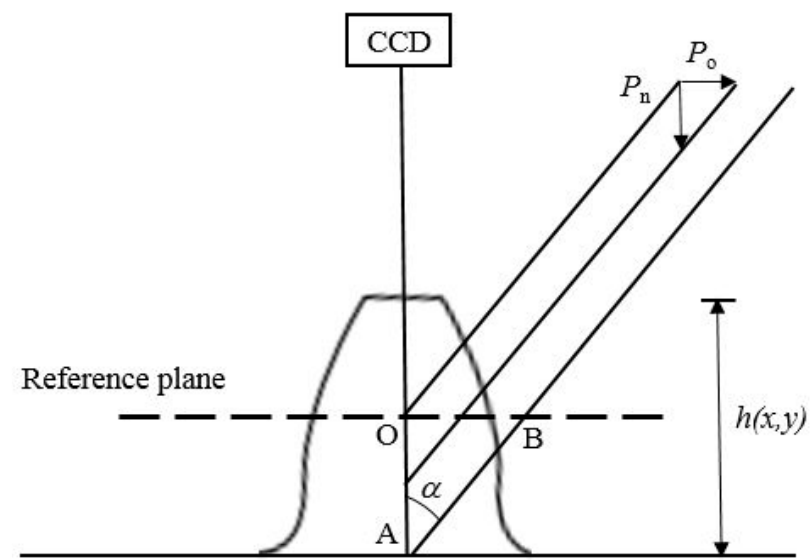
Figure 1. Illustration of the angle formed by the charge-coupled device (CCD) viewing direction and the projection moiré fringe, and a reference plane for the height estimation.